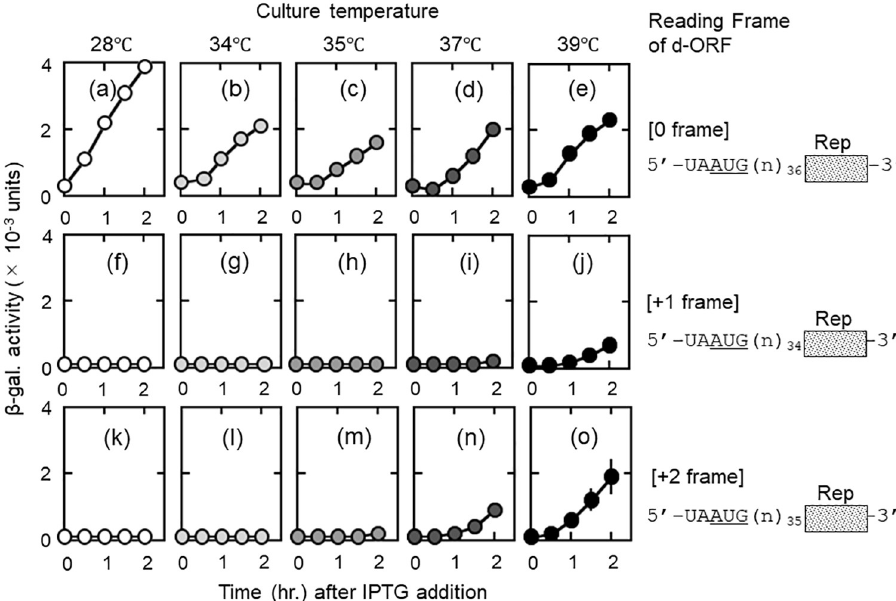
Fig 4. Both high culture temperature and loss of RRF function are required for thermal frameshifts to all frames. LJ14 cells grown at 28˚C were divided into 5 parts and further incubated at various temperatures. Numbers in square brackets shown on the right side of panels represent the reading frame of d-ORF counting from AUG of the junction sequence UAAUG. In panels (a)—(e), AUG of UAAUG is in frame with the reporter lacZ ( Δ 27) gene. In (f)—(j) and (k)—(o), AUG of UAAUG is out of frame with the reporter gene. The nucleotide sequences labelled (n) n are 5’- gguctcaaagcaaaacacaaggaaaacctcgcgaaauacgua-3’ (panels (a)–(e)), 5’-gguctcaaagcaaaacacaaggaaaacctcgcgauacgua-3’ ((f)–(j)), and 5’-gguctcaaagcaaaacacaaggaaaacctcgcgaauacgua-3’ ((k)–(o)). At 39˚C, the temperature is high enough to inactivate RRF and cause thermal frameshift, which is shown by reading at all three frames (panels (e), (j) and